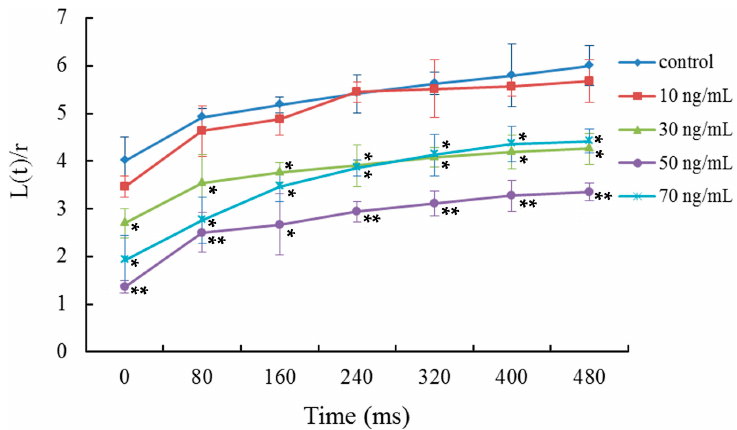
Figure 2. Micropipette aspiration measurements of the viscoelasticity of mDCs treated with different concentrations of VEGF. Relative to the aspiration time, the ratios between the length of cell tongue aspirated into the micropipette, L(t), and the pipette radius, r, were analyzed. Compared with control group, * p < 0.05, ** p < 0.01.